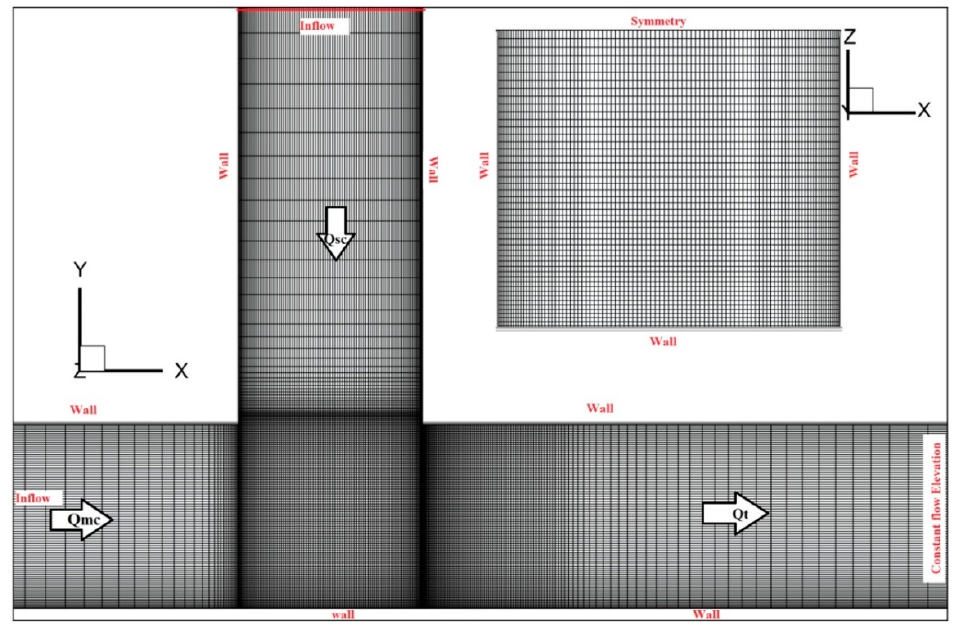
Figure 1. Plan and front view of mesh domain along with boundary conditions.